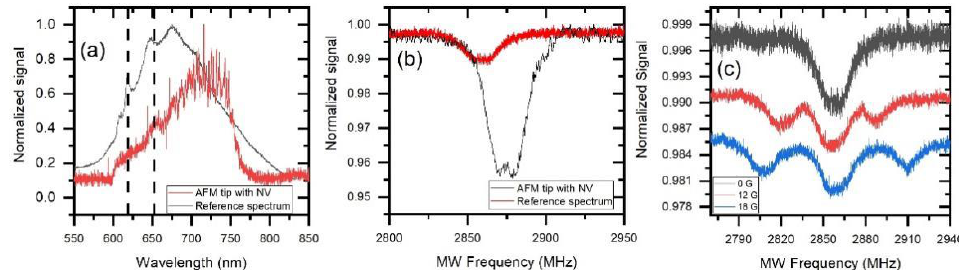
Figure 6. ( a ) Fluorescence from the NV-rich nanodiamond mounted on an AFM tip (red curve), compared with the reference spectrum from nanodiamond with NV centres (black curve). ( b ) ODMR spectrum collected from the AFM tip (red curve), and a reference spectrum from the starting, NV-rich nanodiamond particles. ( c ) ODMR signals for different magnetic field strengths.